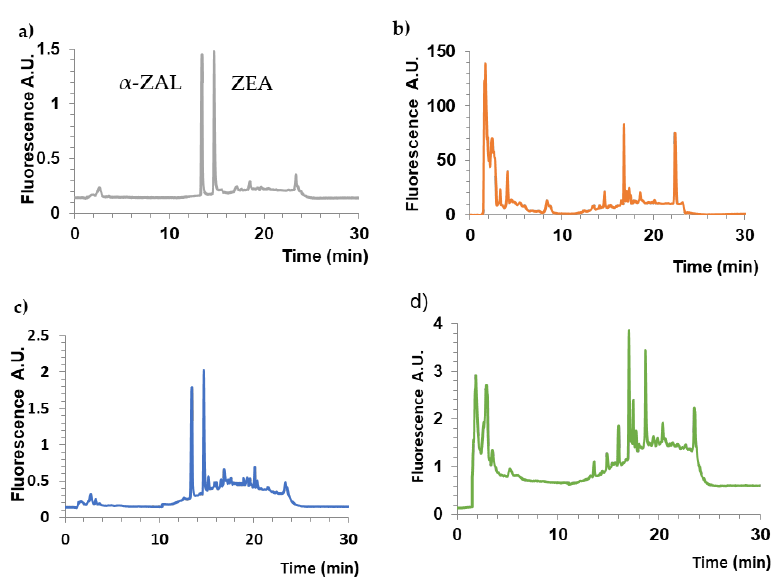
Figure 12. Chromatograms obtained for the standard solutions of zearalenone (ZEA) and its metabolites ( α -zearalenol, α -ZAL) ( a ), untreated urine samples ( b ), MIP-CDHB ( c ), and NIP ( d ) extraction of urine spiked of 100 ng · mL − 1 of each analyte. Table 7. Effectiveness of zearalenone extraction from contaminated urine at four concentration levels when MISPE and immunoassay columns are used. Recoveries (R) and relative standard deviation (RSD) calculated from six